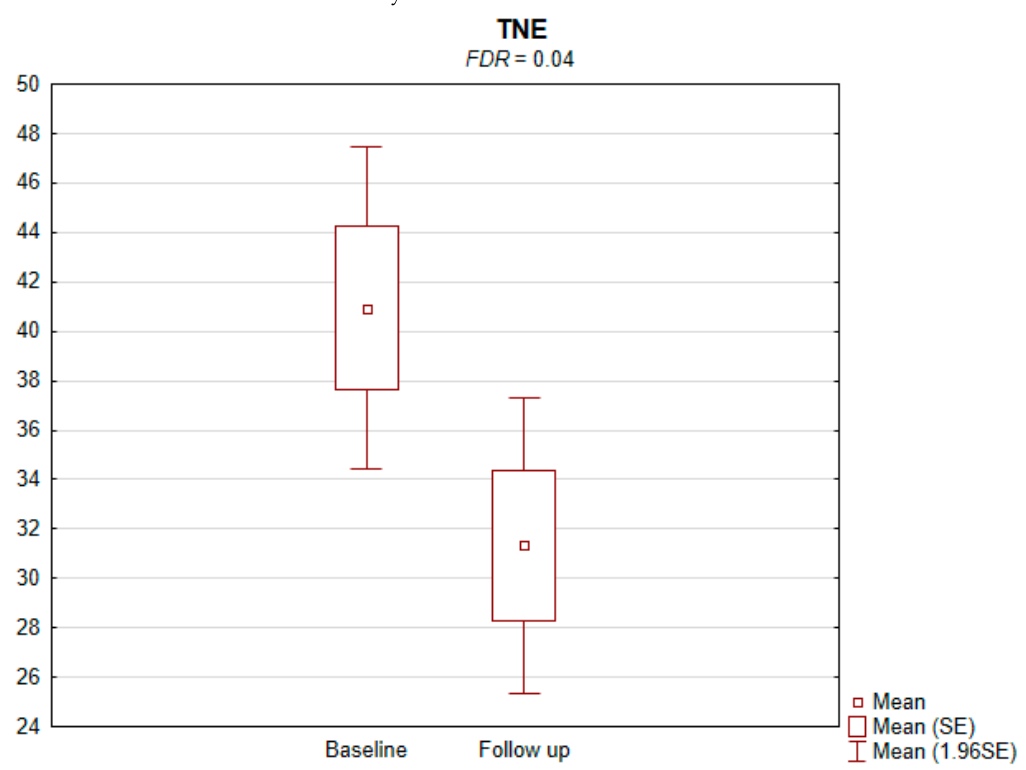
Figure 3. Digit symbol test (DS) on Wechsler Adult Intelligence Scale before and after the intervention. FDR —false discovery rate.